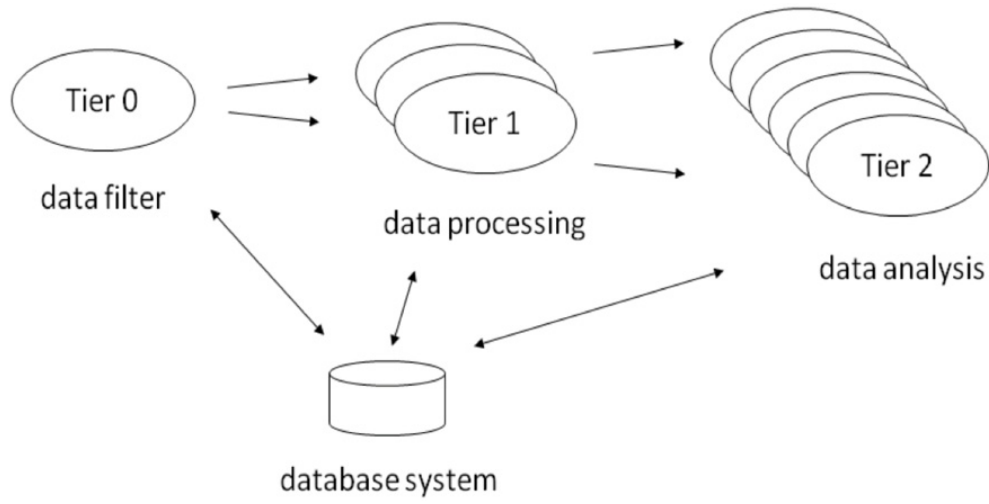
Figure 1. Data Distribution